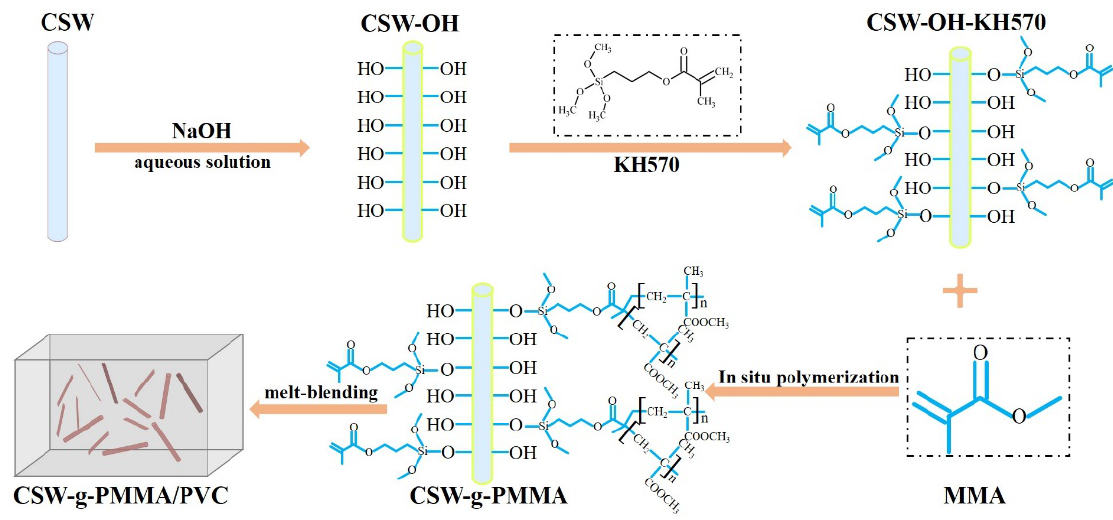
Figure 1. Schematic diagram of PMMA-grafted CSWs for application as fillers in PVC.